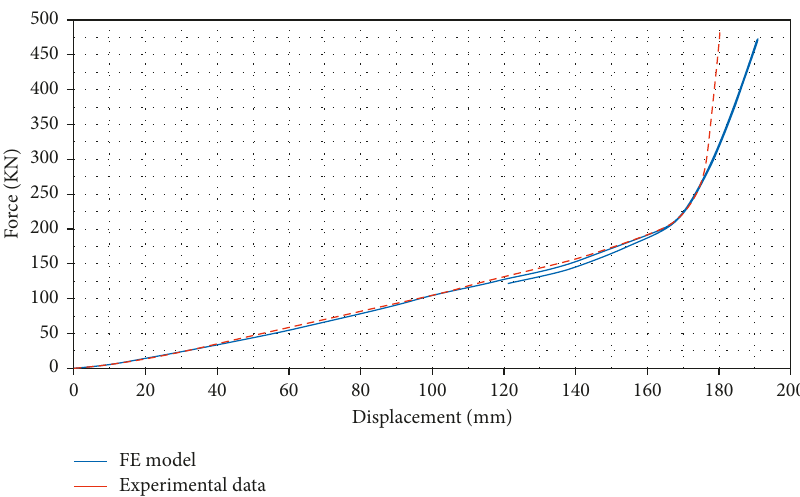
Figure 26: Numerical and experimental vertical forces vs. tyre